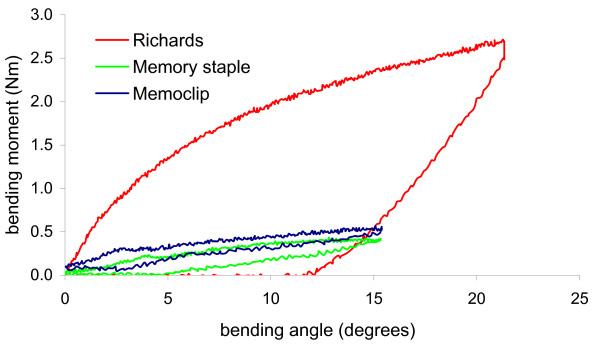
Load displacement curves for different staples in bending.